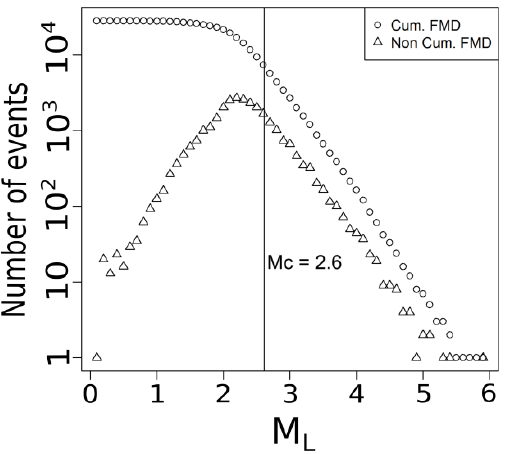
Figure 2. Cumulative and noncumulative frequency-magnitude distributions on logarithmic scale with the black line indicating magnitude of completeness (M C ) for time series during 2006 – 2017.